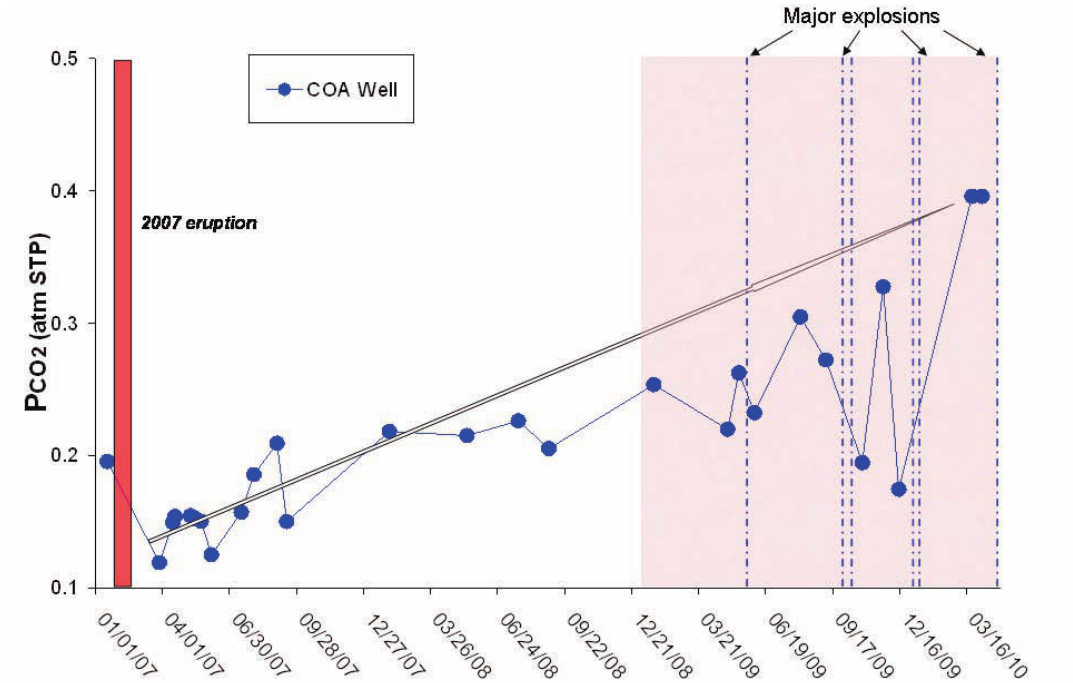
(STP, atm) for the COA well, as acquired with low-frequency sampling. This graph highlights the positive trend Figure 11. Long-term variations in the P CO2 with time (arrow) from the end of the last major eruption of Stromboli volcano (April 2007) to the present. The 2007 eruption (red column) and of P CO2 the major explosions that occurred in the period from January 2009 to June 2010 (red transparent area, vertical blue dashed lines) are